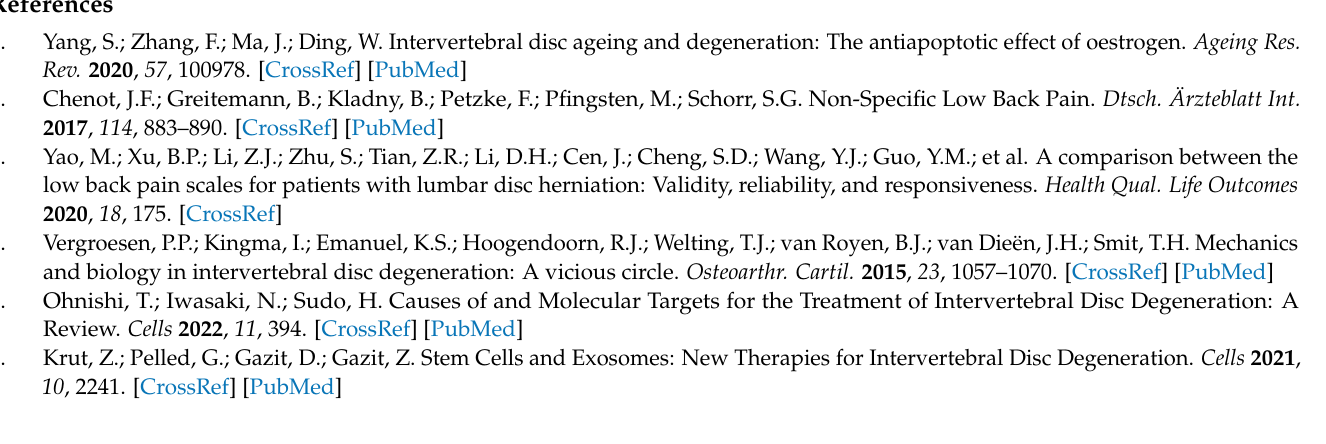
Figure 2. The potential ferroptosis-related pathways in annulus fibrosus cells ( left ) and endplate chondrocytes ( right ). DMT1, divalent metal transporter 1; FTH1, ferritin heavy chain 1; FPN, ferroportin; GPX4, glutathione peroxidase 4; GSH, glutathione; IL-6, interleukin-6; IL-6R, interleukin-6 receptor; LC3, microtubule-associated protein light chain 3; NCOA4, nuclear receptor coactivator 4; ROS, reactive oxygen species; SLC7A11, cystine/glutamate antiporter; TBHP, tert-butyl hydroperoxide; TfR1, transferrin receptor